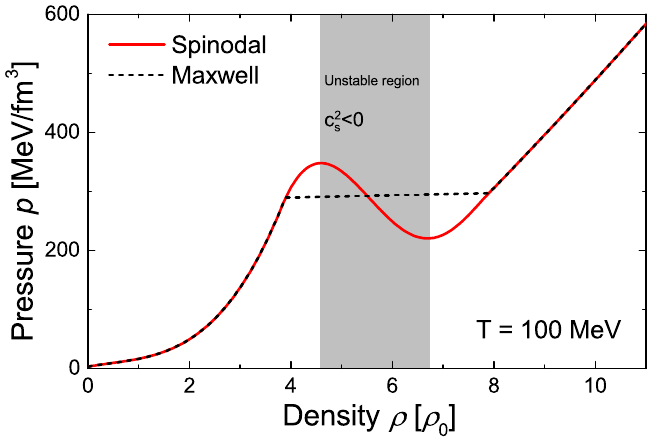
Figure 1 . Pressure as a function of the net baryon density at a (cid:12)xed temperature T = 100 MeV, for both the mechanically unstable spinodal equation of state (solid) and the corresponding stable equation of state (dashed) where the instabilities are removed by means of the standard Maxwell